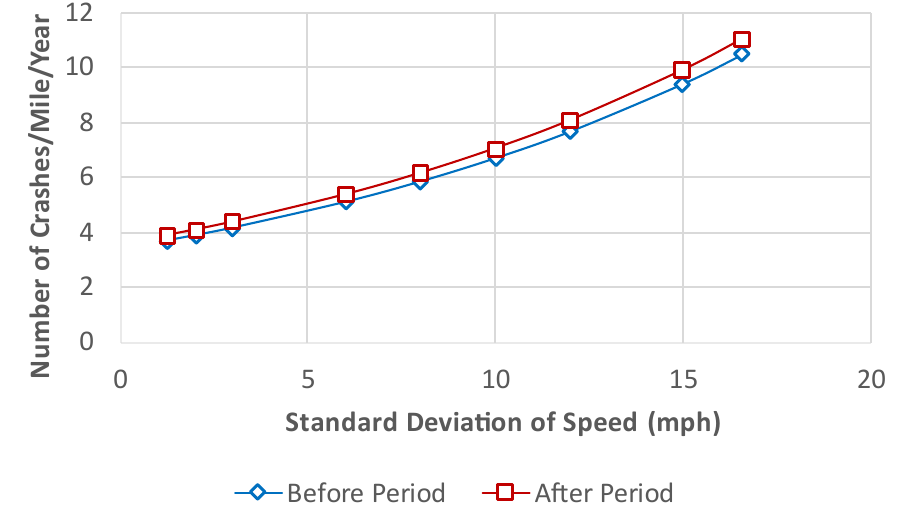
Figure 3 Annual number of crashes for increase sites based on standard deviation of